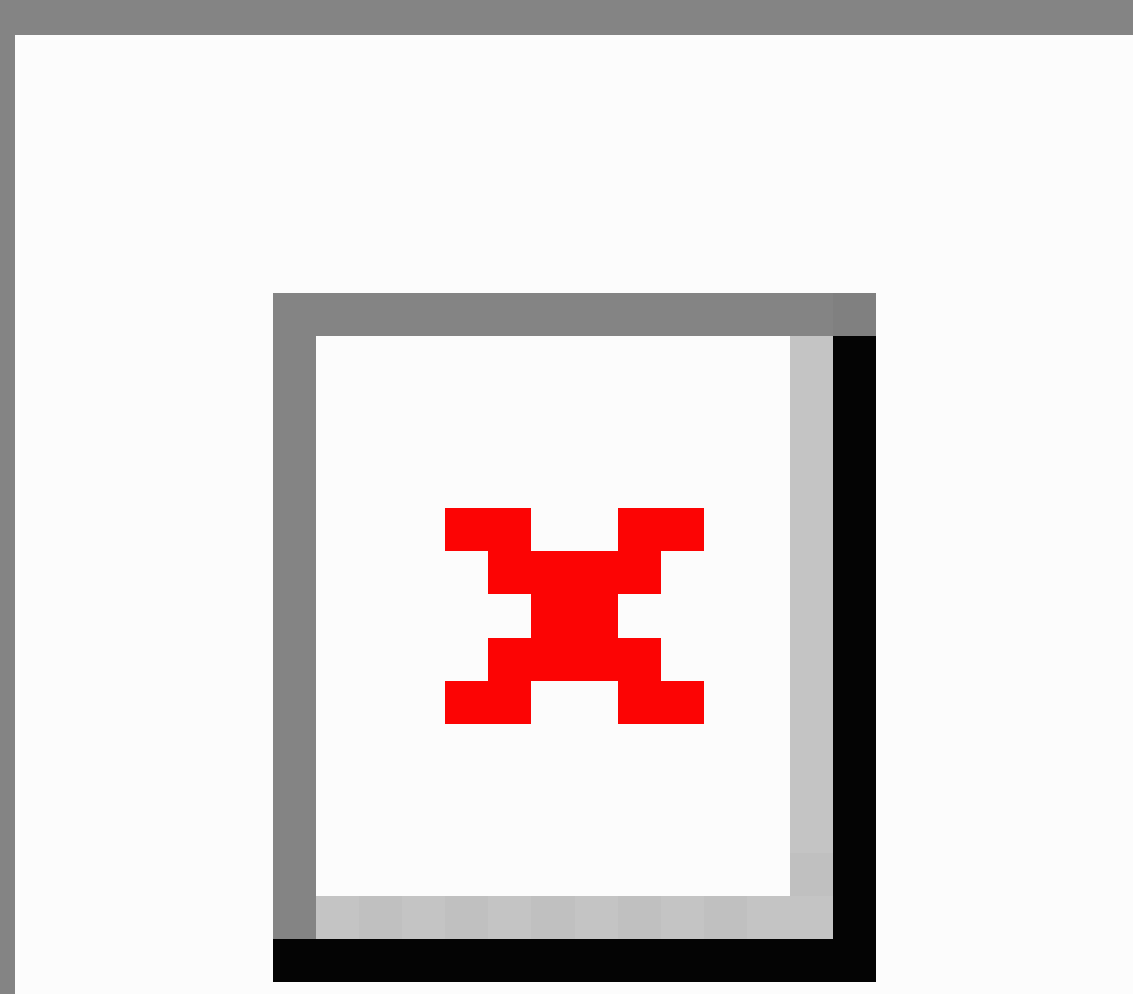
Figure 1. The emergency medical service (EMS) personnel handling with the tablet computer to check the status of